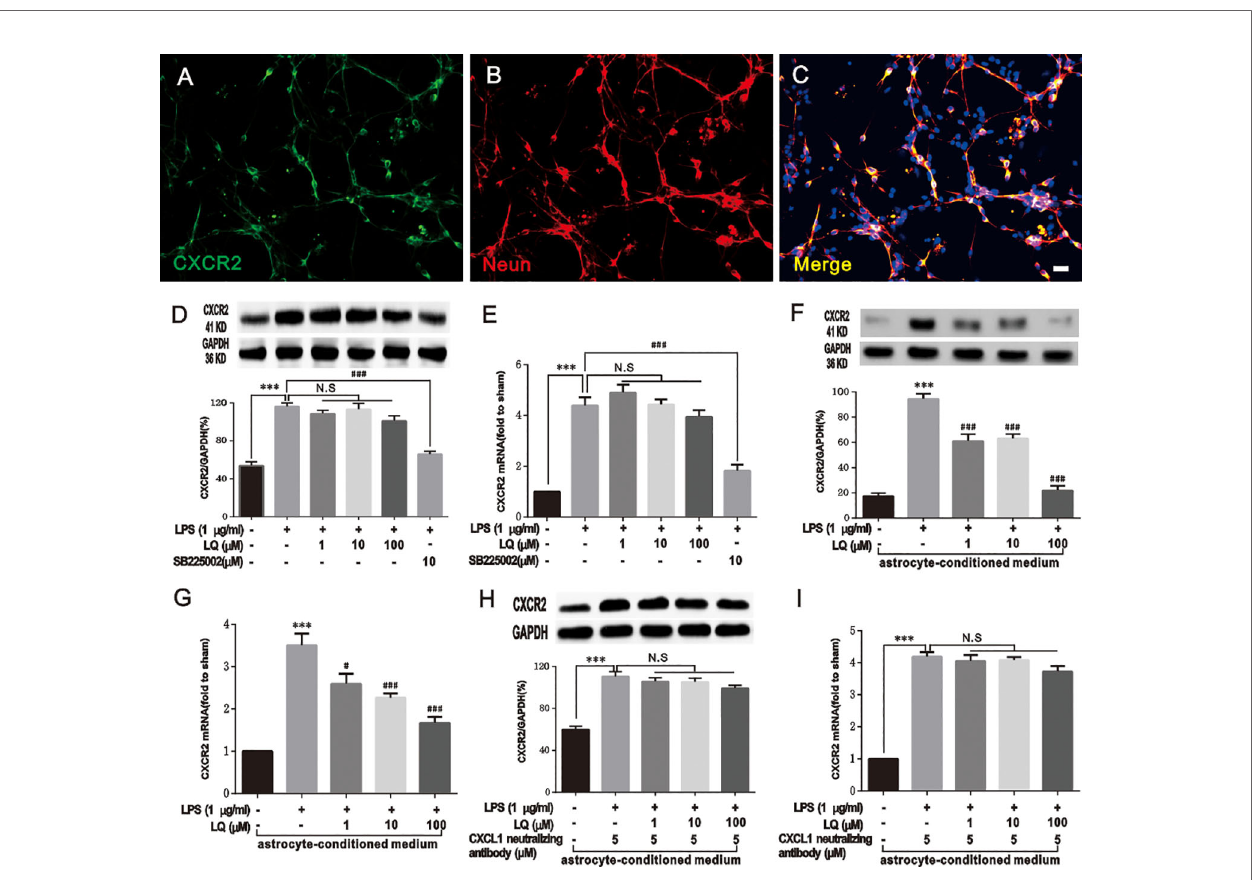
FIGURE 9 | Liquiritin (LQ) indirectly reduces CXCR2 upregulation in primary neurons mediated by astrocyte-conditioned medium. (A – C) Double staining of CXCR2 with NeuN demonstrated the expression of CXCR2 by neurons. Scale bar = 50 mm. (D , E) LQ did not directly act on the increase in LPS-induced CXCR2 in primary neurons (F 5,18 = 35.21, P > 0.05, ***P < 0.001, ### P < 0.001 vs. control, F 5,18 = 40.77, P > 0.05, ***P < 0.001, ### P < 0.001 vs. control; n = 4, one way ANOVA, D, E ). (F , G) LQ indirectly reduced the increase of CXCR2 mediated by astrocyte-conditioned medium (F 4,15 = 63.6, ***P < 0.001 vs. Naive, ### P < 0.001 vs. control, F 4,15 = 26.58, ***P < 0.001 vs. naïve, # P < 0.05, ### P < 0.001 vs. control; n = 4, one way ANOVA, F, G ). (H , I) The astrocyte-conditioned medium incubated with LQ showed no effect on the increase of CXCR2 when CXCL1 was inhibited (F 4,15 = 32.03, ***P < 0.001, P > 0.05 vs. control, F 4,15 = 85.85,***P < 0.001, P > 0.05 vs. control; n = 4, one way ANOVA, H, I ). All data are presented as means ± SEM. N.S., No statistical difference was found between two groups, P >